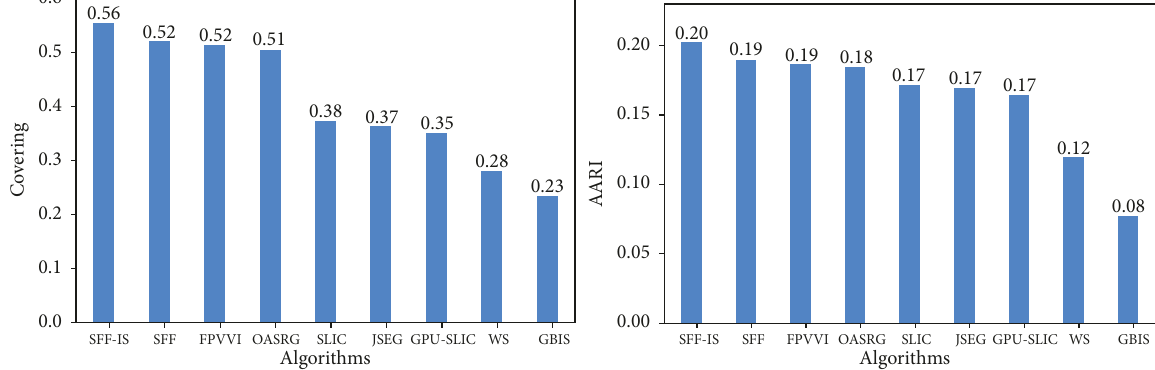
Figure 8: Average AARI and Covering for each method